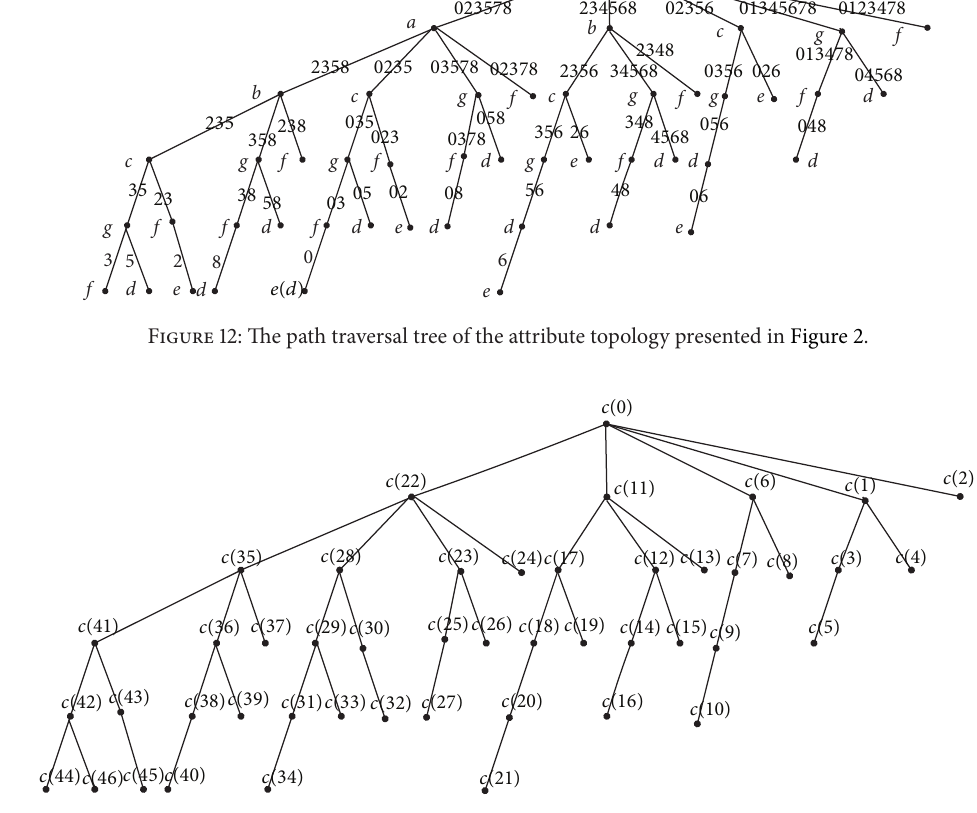
Figure 13: The concept tree of the attribute topology presented in Figure 2.